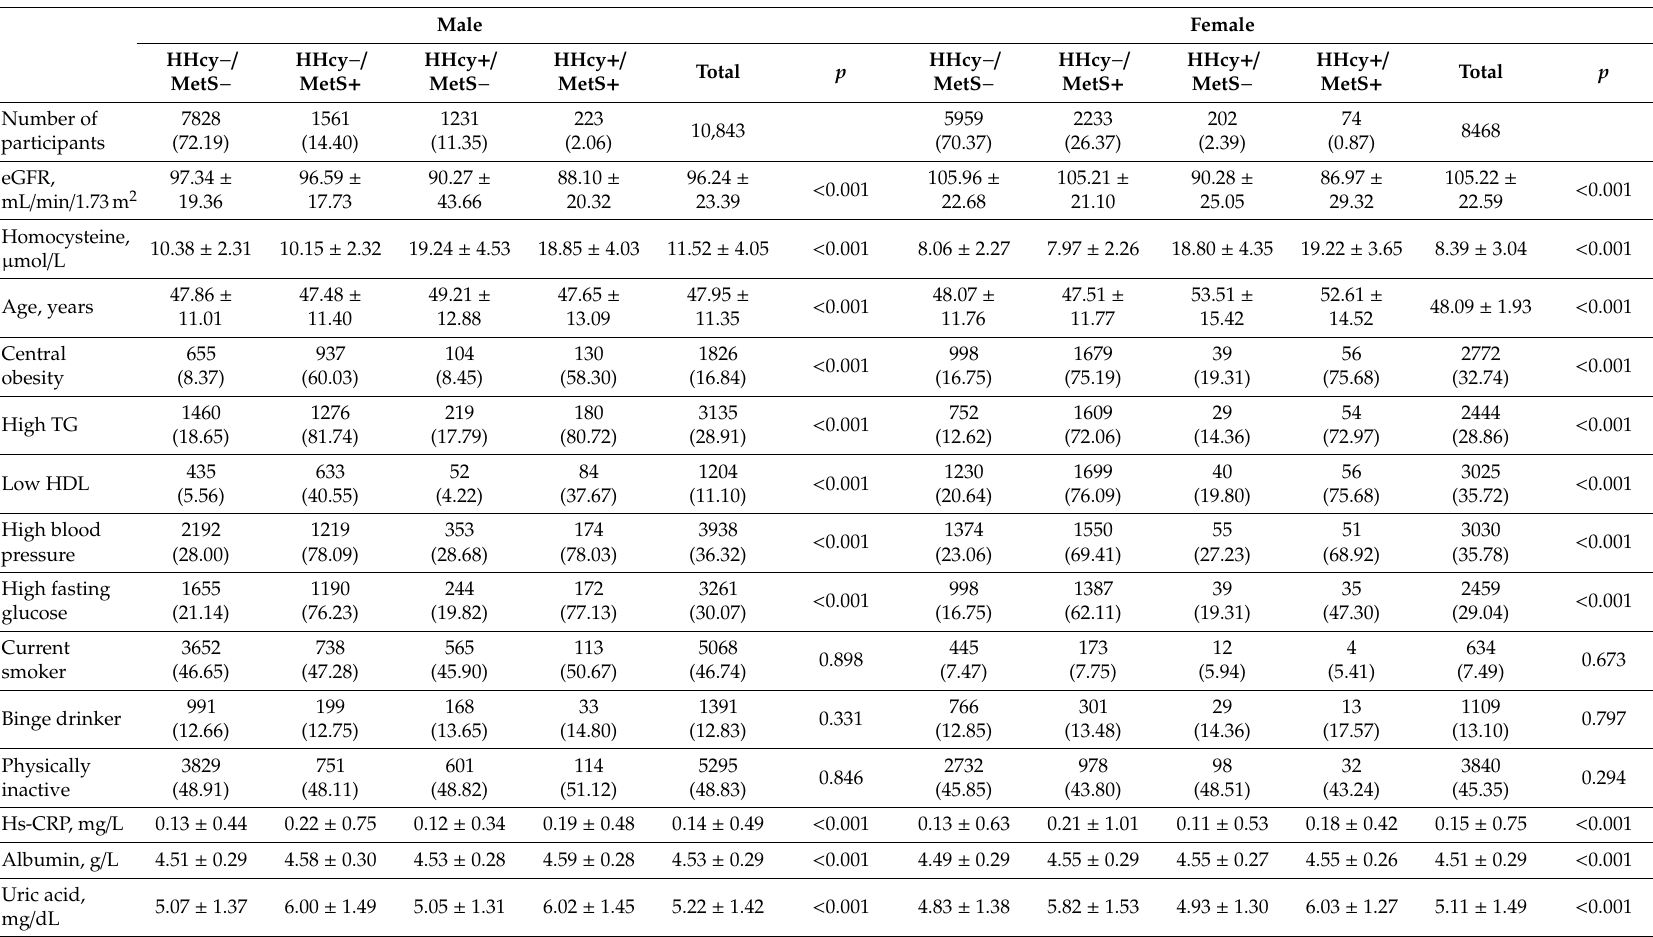
Table 1. Characteristics of the study population according to sex and the four